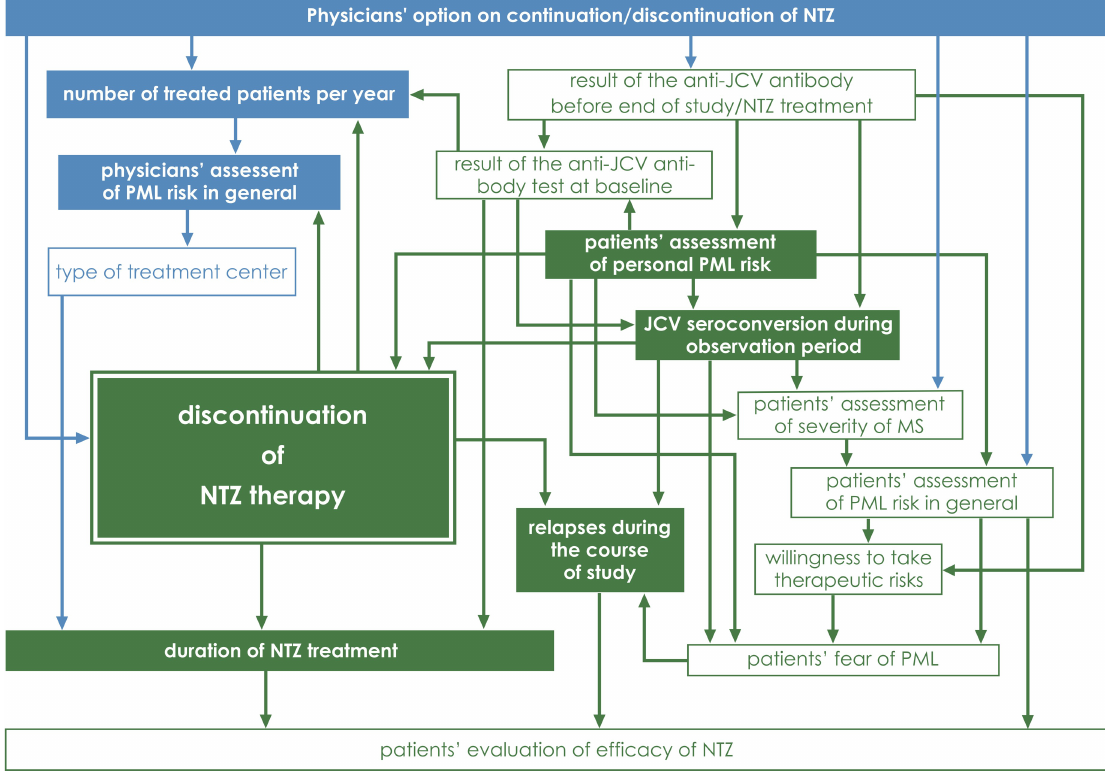
Fig 4. Bayesiannetwork learned from the information of patients of the subgroups A-C and associatedneurologists with the bnlearn R package. All patient-related factors are colored in green and all physician-related factors are colored in blue. JCV seroconversion during observation period, physicians’ opinionon continuation/discontinuation of NTZ in the individual patient, assessment of PML risk in general,numberof treated patients per year and patients’perceptionof personal PML risk, durationof NTZ treatment and relapses duringthe course of the study were directly associated with patients’discontinuation of NTZ therapy (those factors are picturedas completelycolour-filledboxes). For all other examinedfactors we found no relationship with NTZ treatment cessation (those factors are pictured as white